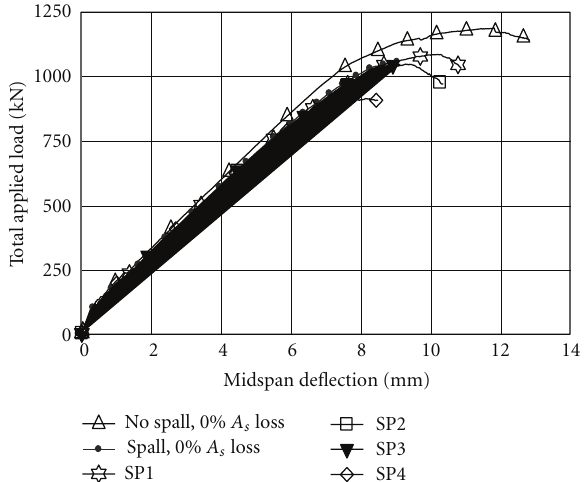
Figure 13: FE predicted load-deflection response for models with spatially distributed, local maximum section loss in stirrups.